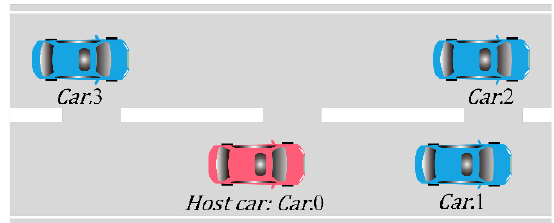
Figure 1. Driving environment and vehicle code name.